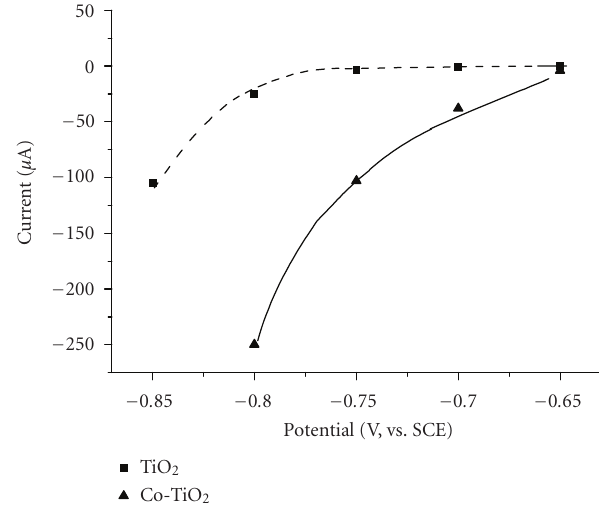
Figure 3: Cyclic voltammetry curves for O 2 reduction on TiO 2 and Co(0.5%)-TiO 2 in the dark. Sweep rate: 20mV s − 1 . Electrolyte: 0.1 M NaOH. Electrodes geometric area: 2cm 2